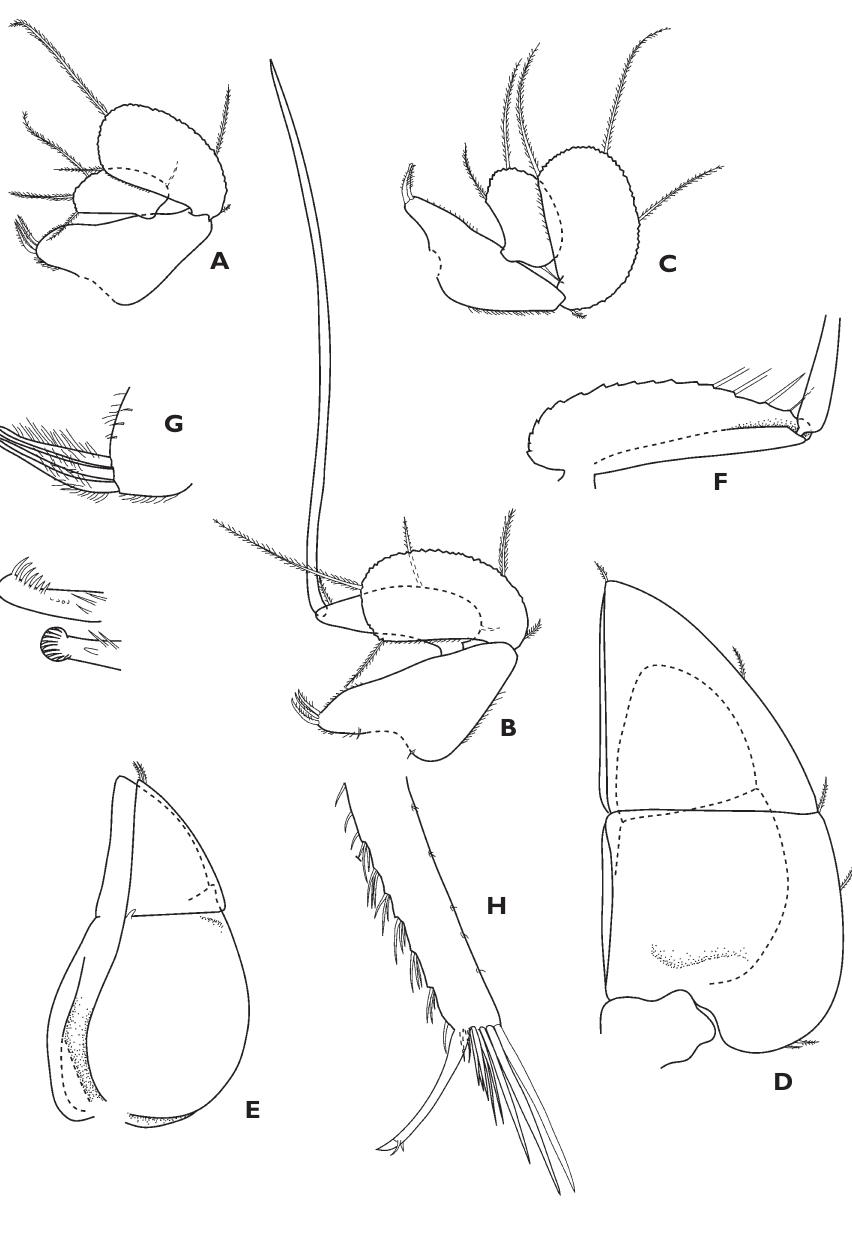
Figure 12. Myopiarolis koro sp. n. Holotype, except D, E, female paratype. A–E pleopods 1–5 respectively F pleopod 2 endopod detail G pleopod 1 peduncle H pereopod 7 propodus, distal margin and